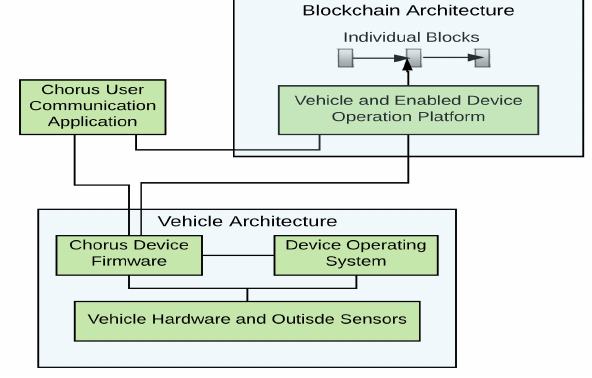
Figure 14. VANETs setup via blockchain, inspired by